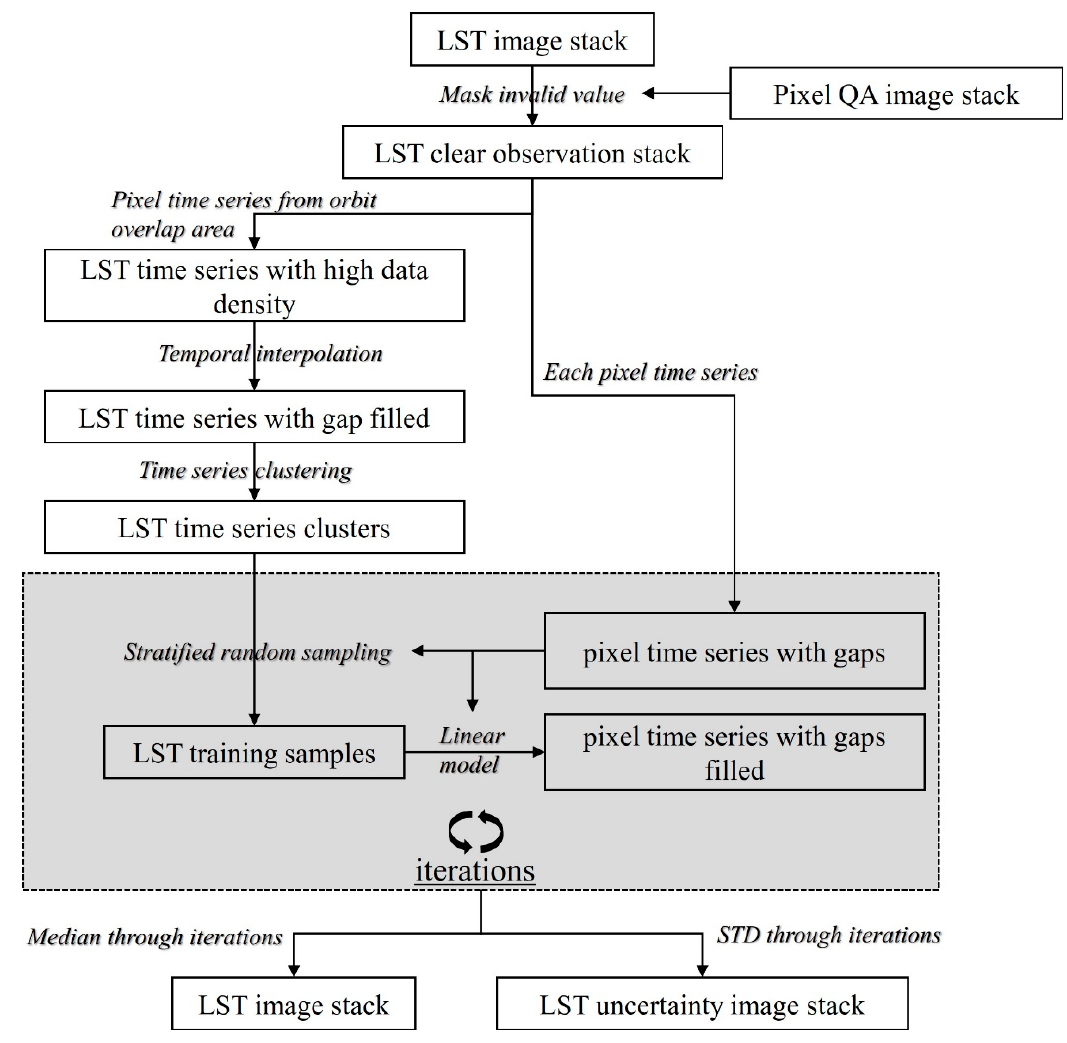
Figure 3. Workflow of the gap-filling algorithm.